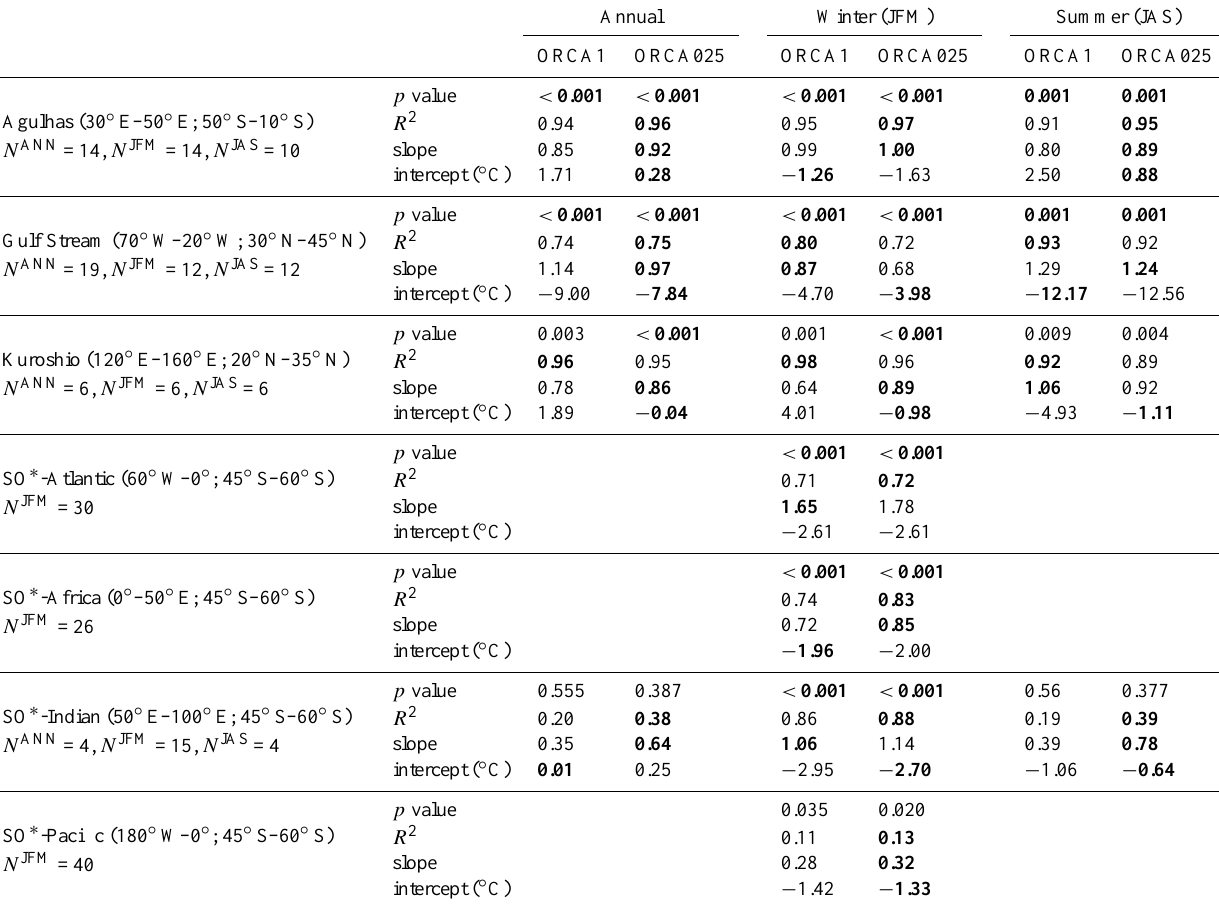
Table 2. Regional statistical analysis (linear regression test) between the simulated and reconstructed SSTs summarized by the p value, the correlation coefficient, the slope and the intercept (in ◦ C) of the regression line. N is the sample size of the regional MARGO data for each period. In bold, the most significant